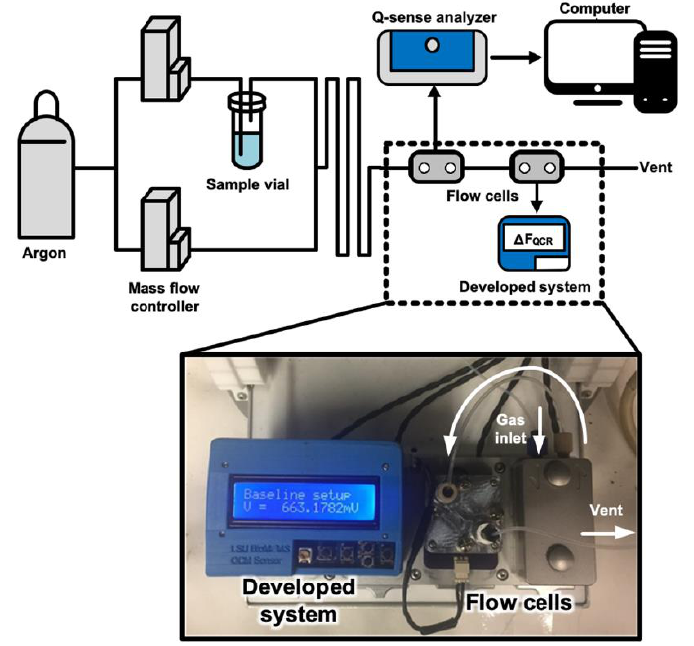
Figure 3. The experimental setup to validate the developed handheld instrument with the conven- tional benchtop instrument.